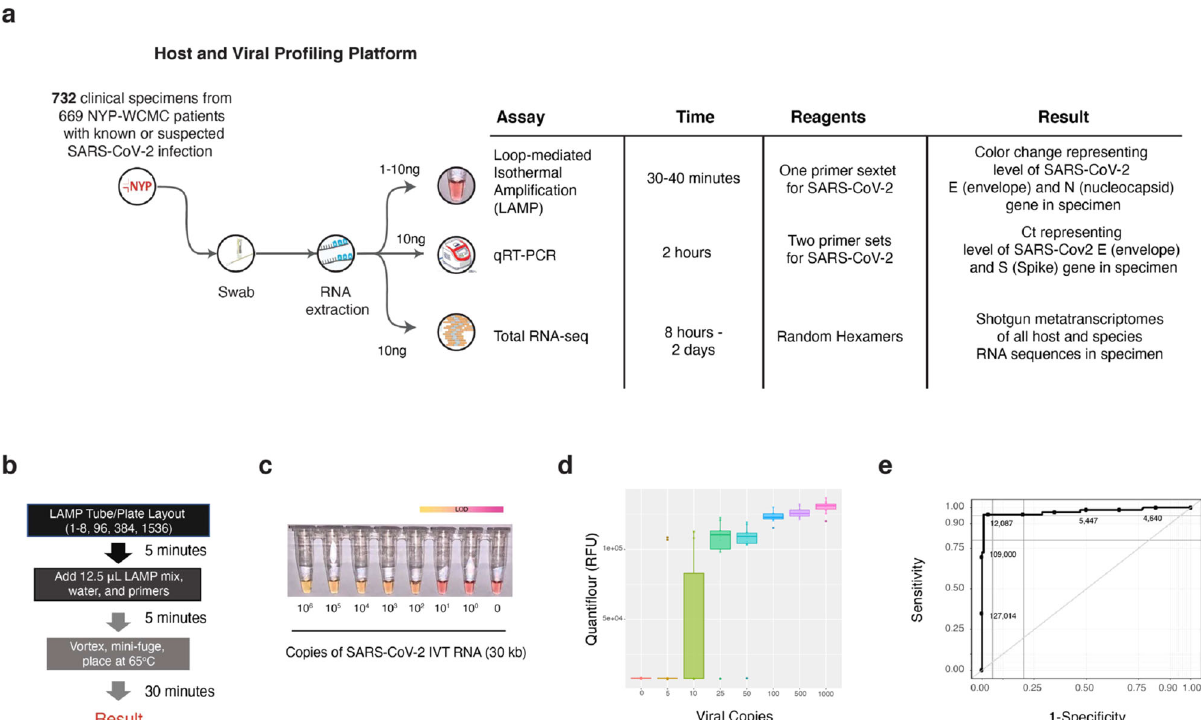
Fig. 1 Sample processing, the loop-mediated isothermal (LAMP) reaction and synthetic RNA validation. a Clinical samples collected with nasopharyngeal (NP) swabs were tested with RNA-sequencing, qRT-PCR, and LAMP. b The test samples were prepared using an optimized LAMP protocol from NEB, with a reaction time of 30 min. c Reaction progress was measured for the Twist SARS-CoV-2 synthetic RNA ( MT007544.1 ) from 1 million molecules of virus 4 , then titrated down by log 10 dilutions. The colorimetric fi ndings of the LAMP assay are based on a yellow to pink gradient with higher copies of SARS-CoV-2 RNA corresponding to a yellow color. The limit of detection (LoD) range is shown with a gradient after 30 min between 10 and 100 viral copies (lower right). d Replicates of the titrated viral copies using LAMP, as measured by QuantiFluor fl uorescence over 201 patient samples. e The sensitivity and speci fi city of the LAMP assay from 201 patients (132 negative and 69 positive for SARS-CoV-2, as measured by qRT-PCR). Thresholds are DNA quanti fi ed by the